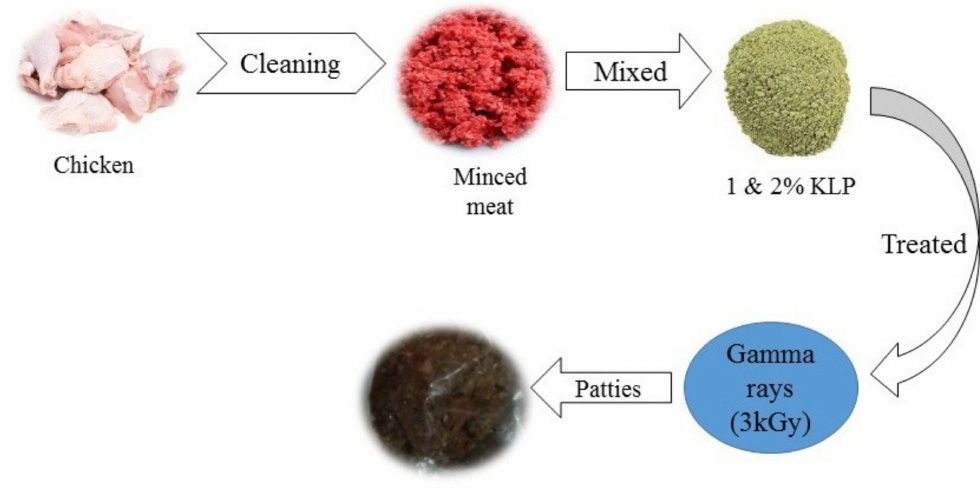
Figure 2. Kale leaf powder- and gamma irradiation-treated chicken